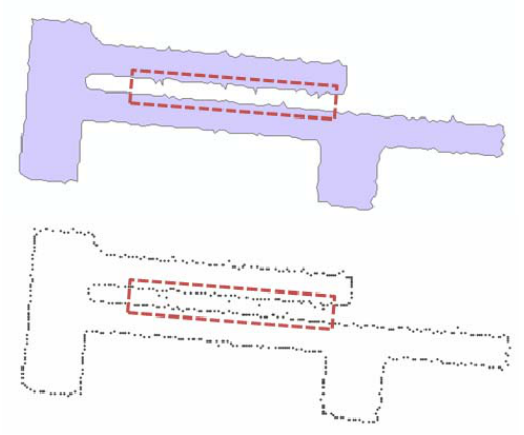
Figure 5. Noise points obtained using the conventional method